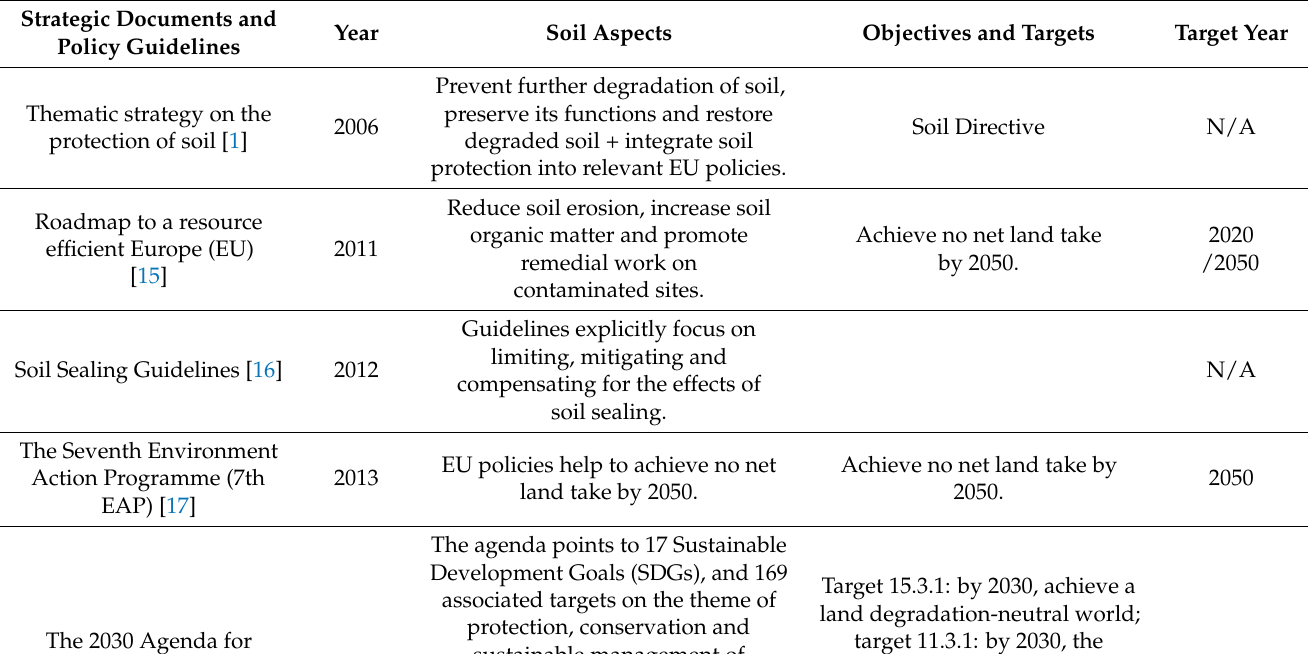
Table 2. Relevant initiatives in the framework of soil protection: the objectives they intend to achieve are indicated with the target